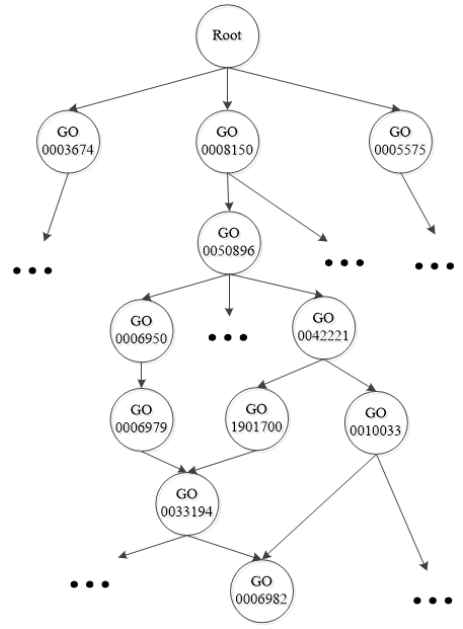
Figure 1. A fraction of the Gene Ontology